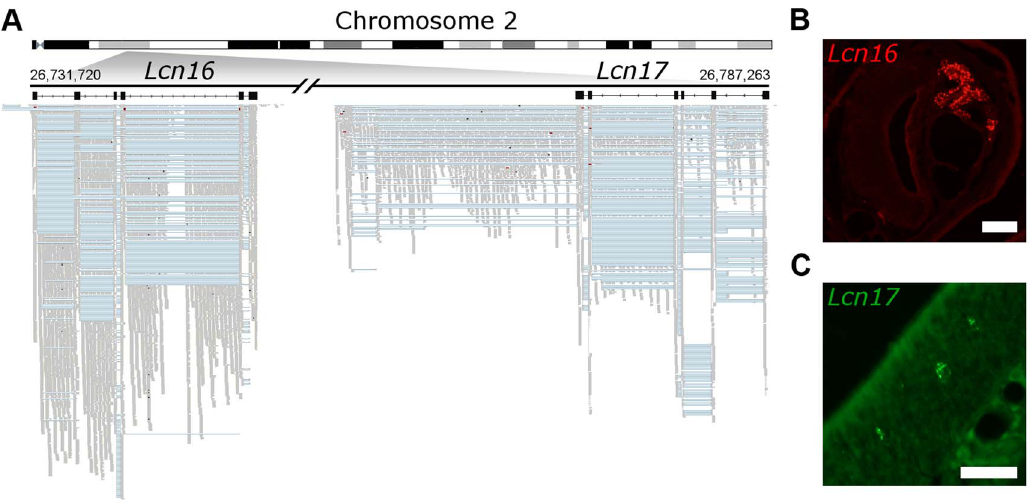
Figure 8. Novel genes are expressed in olfactory organs. (A) Chromosome 2 is schematized on the top and the locus where two previously unidentified genes were found is amplified below. In black are Lcn16 and Lcn17 gene models, where boxes correspond to the exons. The mapped RNAseq reads are below: each read is drawn in grey and blue lines join read fragments that span exon junctions. Black segments within the reads indicate indels. (B) In situ hybridization reveals Lcn16 is expressed in glandular tissue of the VNO and (C) Lcn17 is expressed in cells within the main olfactory epithelium. Scale bars: (B) 100 m m, (C) 50 m m.